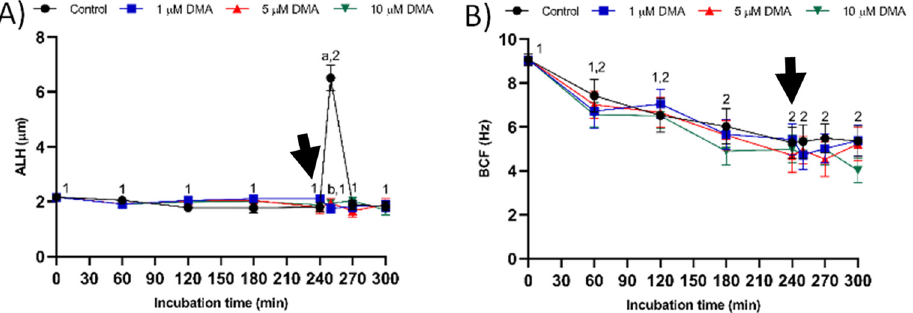
Figure 6. Kinematic parameters ALH ( A ) and BCF ( B ) during in vitro capacitation in the control and samples blocked with 1, 5, and 10 µM DMA. Different letter superscripts indicate significant differ- ences between control and blocked samples within a single time point ( p < 0.05). Different